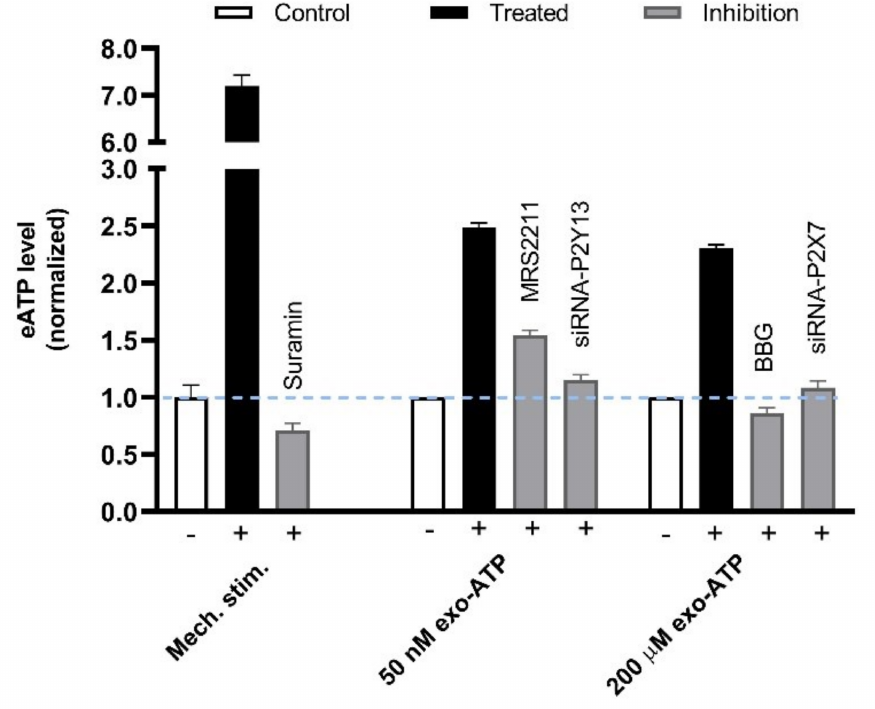
Figure 18. P2Y 13 /P2X 7 receptors-mediated secondary ATP release from MCs in response to mechani- cal stimulation. (Left columns), Rat MCs (RBL-2H3 cell line) were irritated by medium displacement that was controlled by electric pipette gun resulting in 6-folds elevation of ATP released to the extracellular space. Such mechanosensitive ATP release could be dampened by the presence of Suramin (100 µ M) that was pre-introduced to cells 20 min before stimulation. (Middle columns), 50 nM exogenous ATP (exo-ATP) triggered endogenous ATP release. Exo-ATP was introduced to cells and contained eATP level was assayed immediately. MRS2211 ( n = 13), a specific antagonist of P2Y 13 , or P2Y 13 gene interference ( n = 4) was used to suppress 50 nM exo-ATP-mediated secondary ATP release. (Right columns), 200 µ M exo-ATP triggered endogenous ATP release. BBG ( n = 4), a specific antagonist of P2X 7 , or P2X 7 gene interference ( n = 4) was used to suppress 200 µ M exo-ATP-mediated secondary ATP release. Data are means + SEM ( n = 3–11) and are based on Shen et al. (2020)